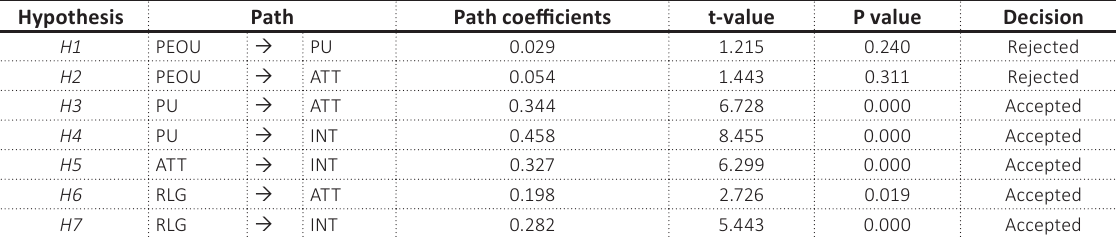
Table 4. Structural model hypothesis testing